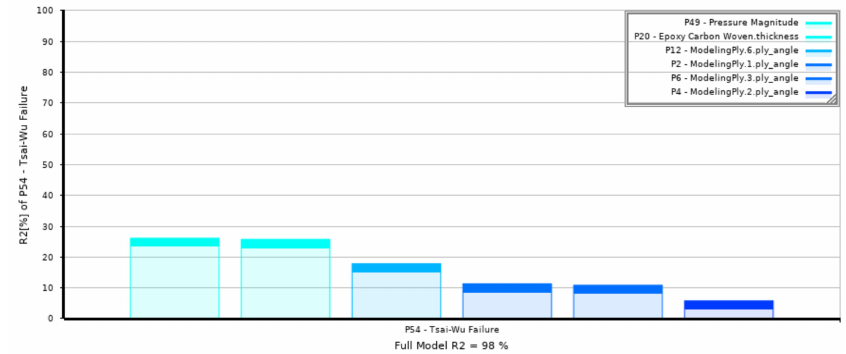
Figure 24. Sensitivities of Tsai-Wu